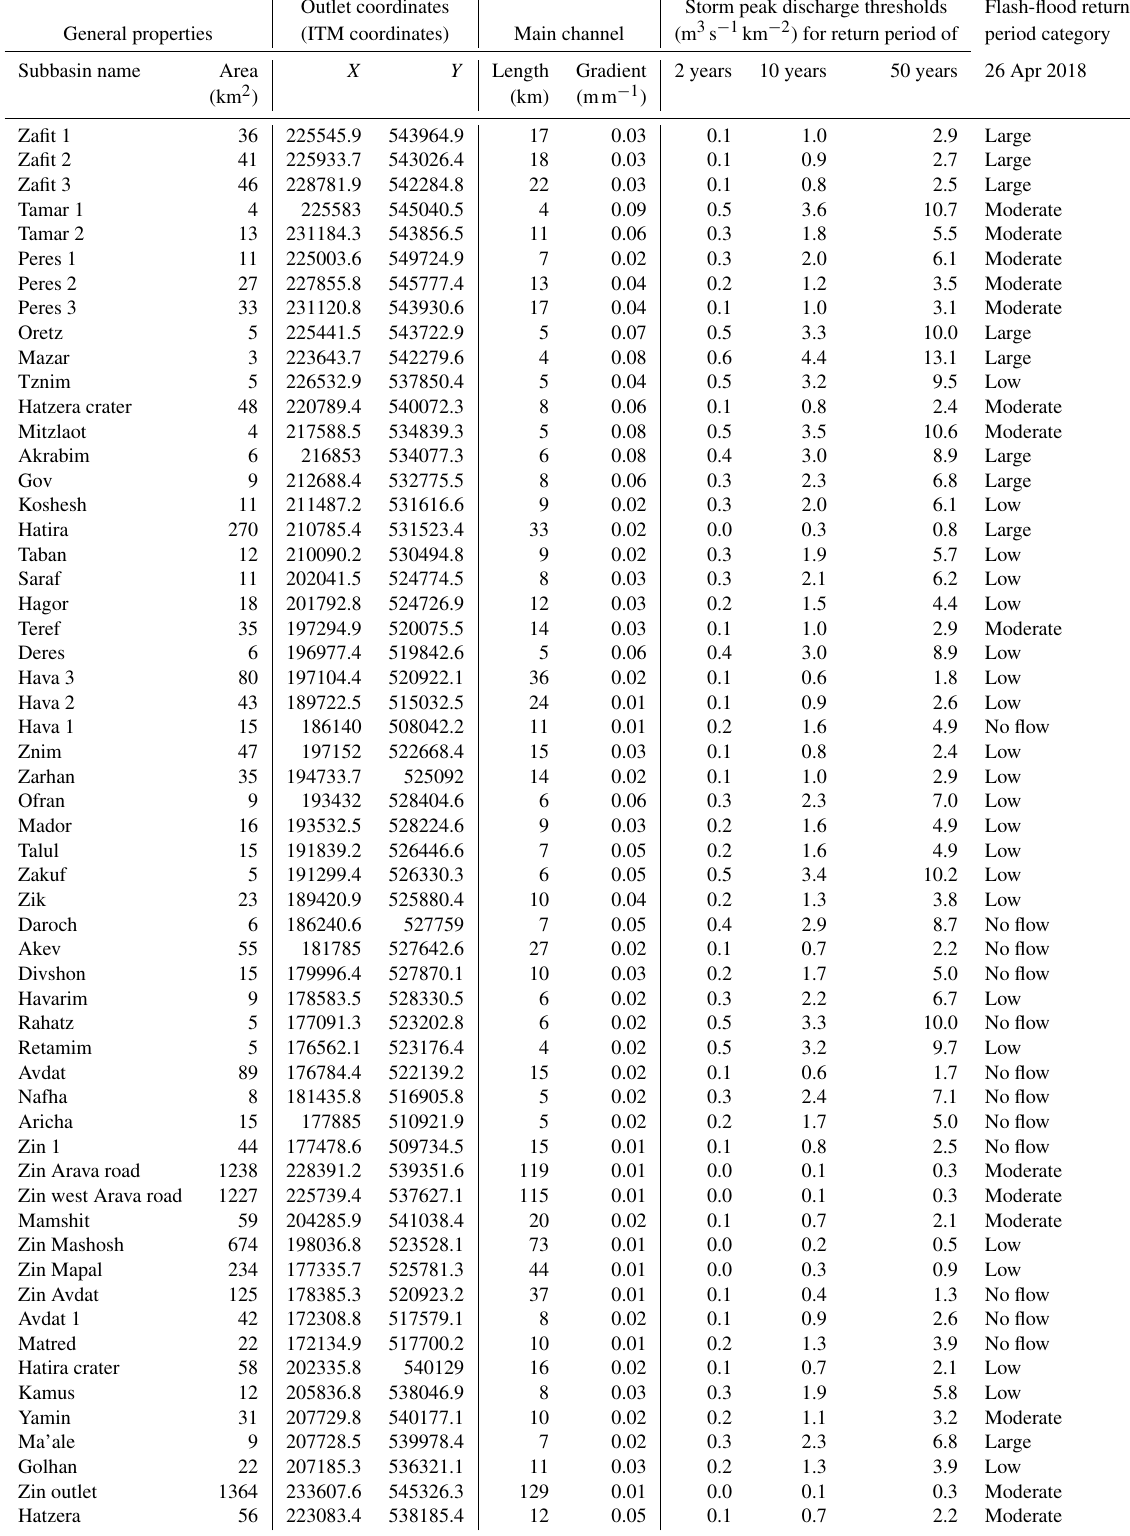
Table 2. Zin subbasin properties, peak discharge for return periods using generalized extreme value (GEV) fit, and the estimated flash-flood return period category based on the modeled peak discharge of 26 April. ITM signifies Israeli Transverse